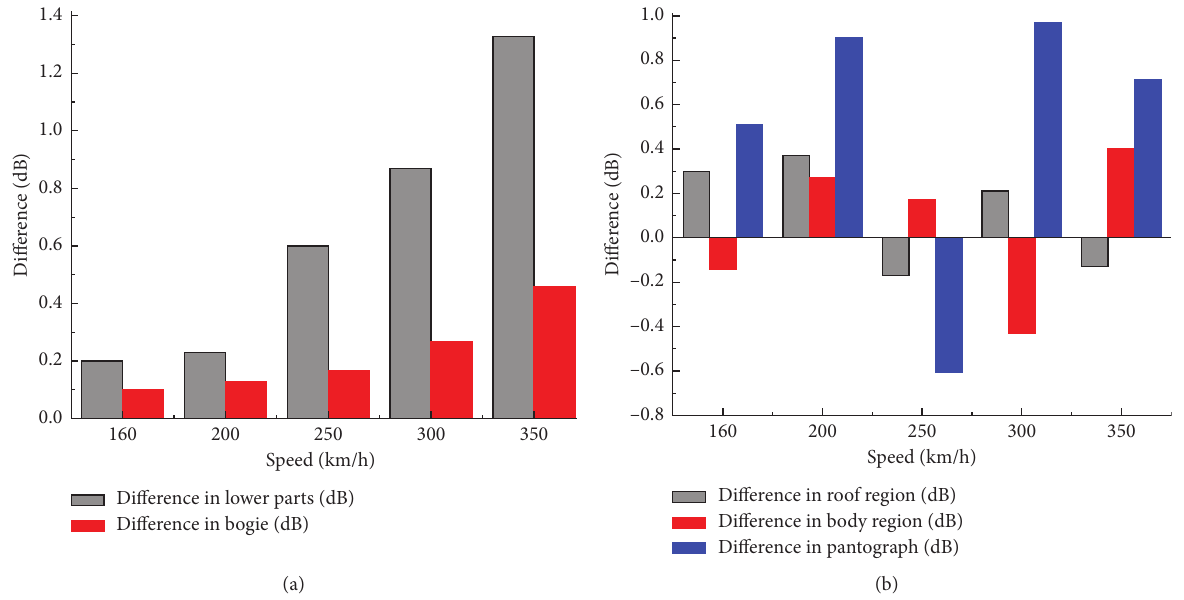
Figure 10: Difference in the noise of source regions between the embankment and viaduct sections. (a) Difference in lower parts and bogie region between the embankment and viaduct sections. (b) Difference in roof, body, and pantograph regions between the embankment and viaduct